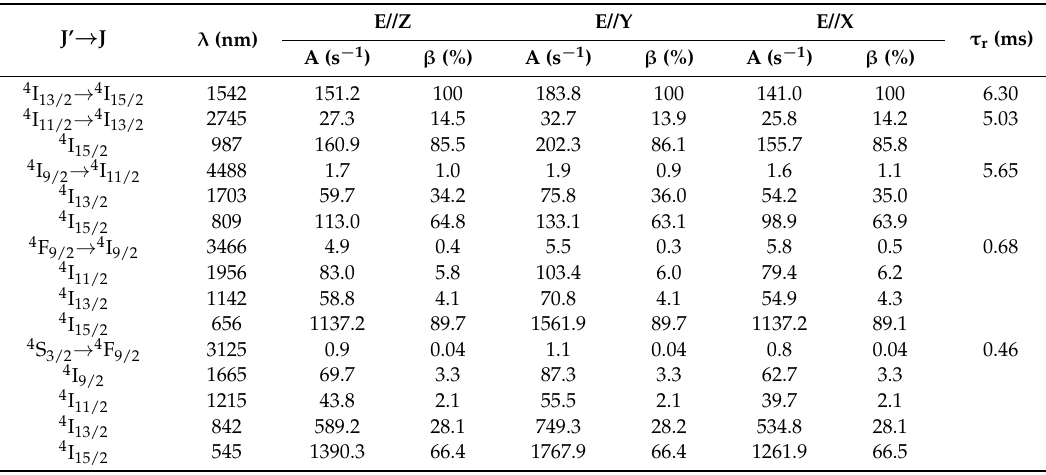
Table 2. Calculated radiative transition rates A, luminescence branching ratios β , and radiative lifetimes τ r of the Er:Yb:GMB